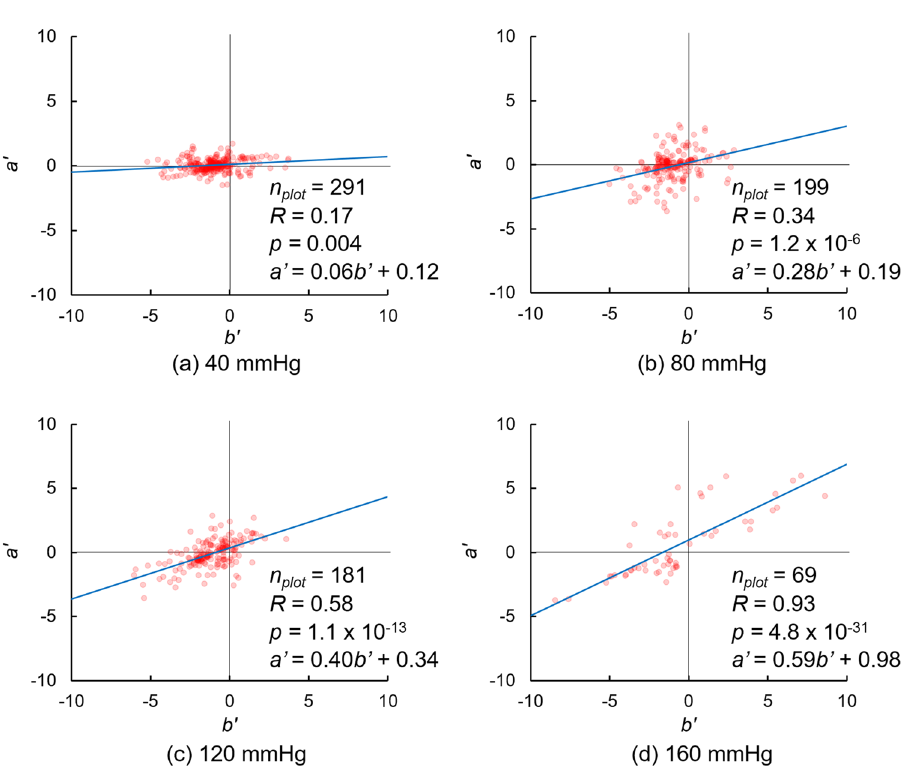
Figure 5. Plots of a’ and b’ as given by Eq. (8) at intraluminal pressures of ( a ) 40, ( b ) 80, ( c ) 120, and ( d ) 160 mmHg. n plot , number of plots. These graphs are obtained from the images shown in Figs. 3 and 4. The correlation coefficient R was tested using the Student’s t -test. The graph was created using the Microsoft Excel for Microsoft 365 MSO